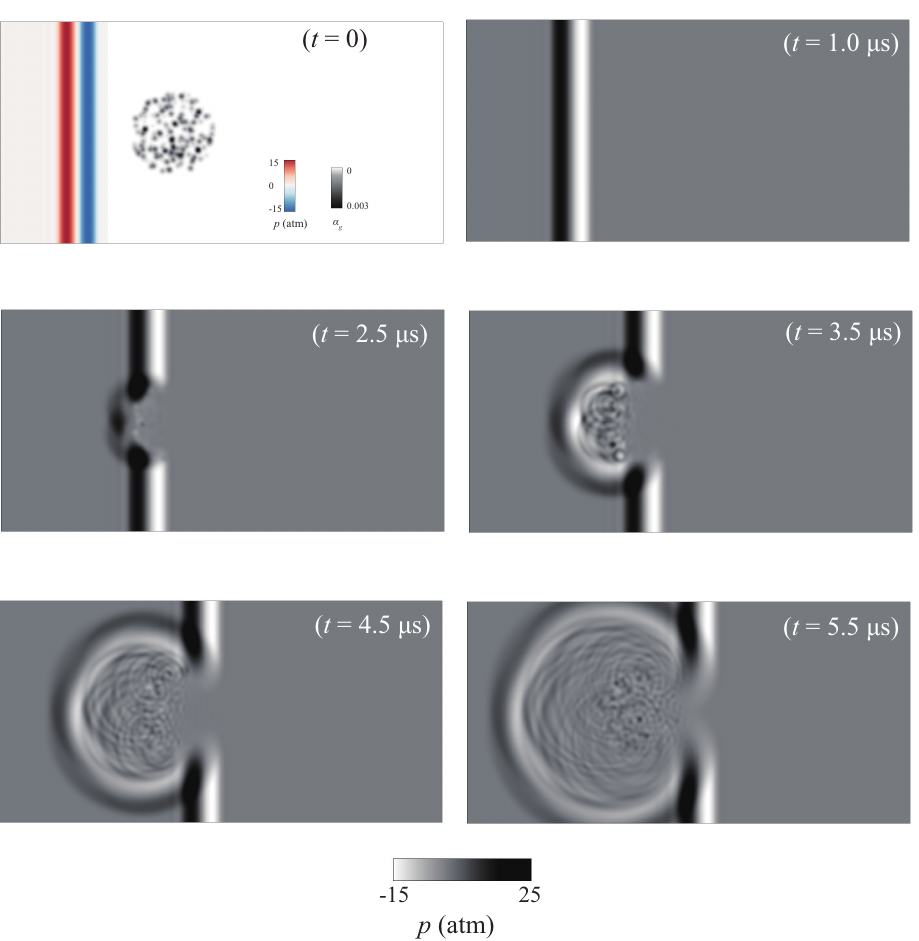
Figure 9. The pressure field induced by the bubble cluster when the bubble cluster interacts with a sinusoidal pulse. The initial state and the pressure field at 1.0 µ s, 2.5 µ s, 3.5 µ s, 4.5 µ s, and 5.5 µ s are shown.